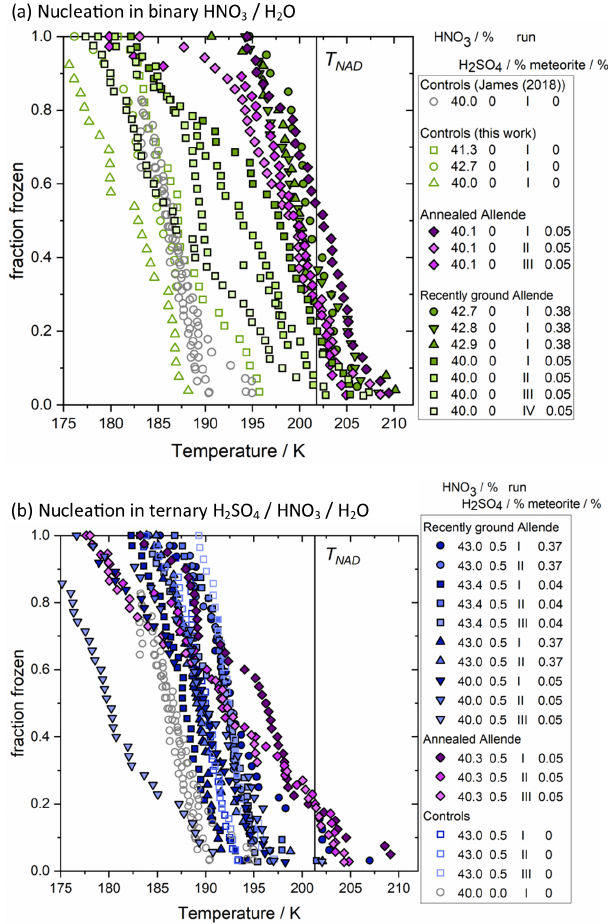
Figure 3. Fraction frozen results for meteoric fragment analogues: (a) binary solution and (b) ternary solution. Symbol shape varies for each experiment and shading for repeats, which were at intervals of approximately 1h with the sample suspension stored at < 270K in between. Open symbols show control experiments, open grey cir- cles are data from James et al. (2018). Legend shows the concentra- tion of acid species and nucleating particles and the repeat status for each data set. The melting temperature of NAD in a 40wt% HNO 3 solution is indicated by a vertical line. The data are summarised in Table 1. Uncertainty in temperature is 1K, see Sect.